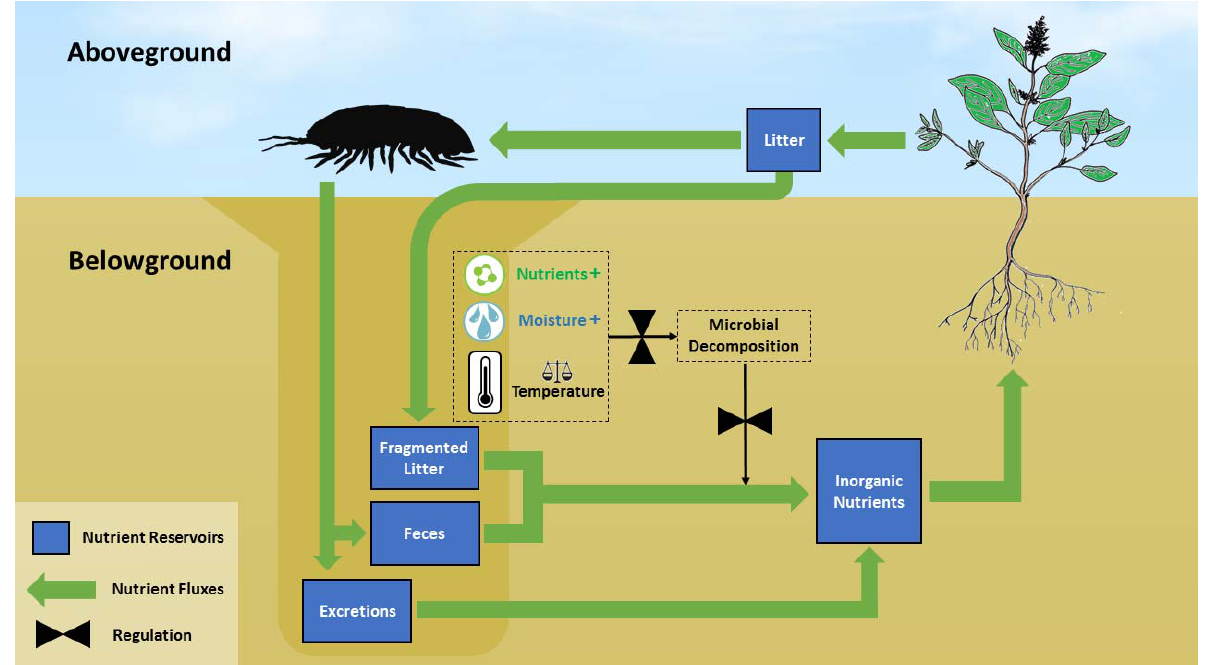
Figure 1. The vertical nutrient recycling loop (VRL) hypothesis: detritivorous macro-arthropods account for a major part of litter removal from the desert surface. Fragmented litter, fecal pellets, and excreted nutrients accumulate within and around arthropod burrows. Mineralization of organic matter within the burrow is enhanced due to climatic and nutrient facilitation, resulting in further soil fertilization. Desert plants utilize the moister deep soil to acquire nutrients from enriched patches around arthropod burrows, completing a vertical rather than a shallow nutrient loop.